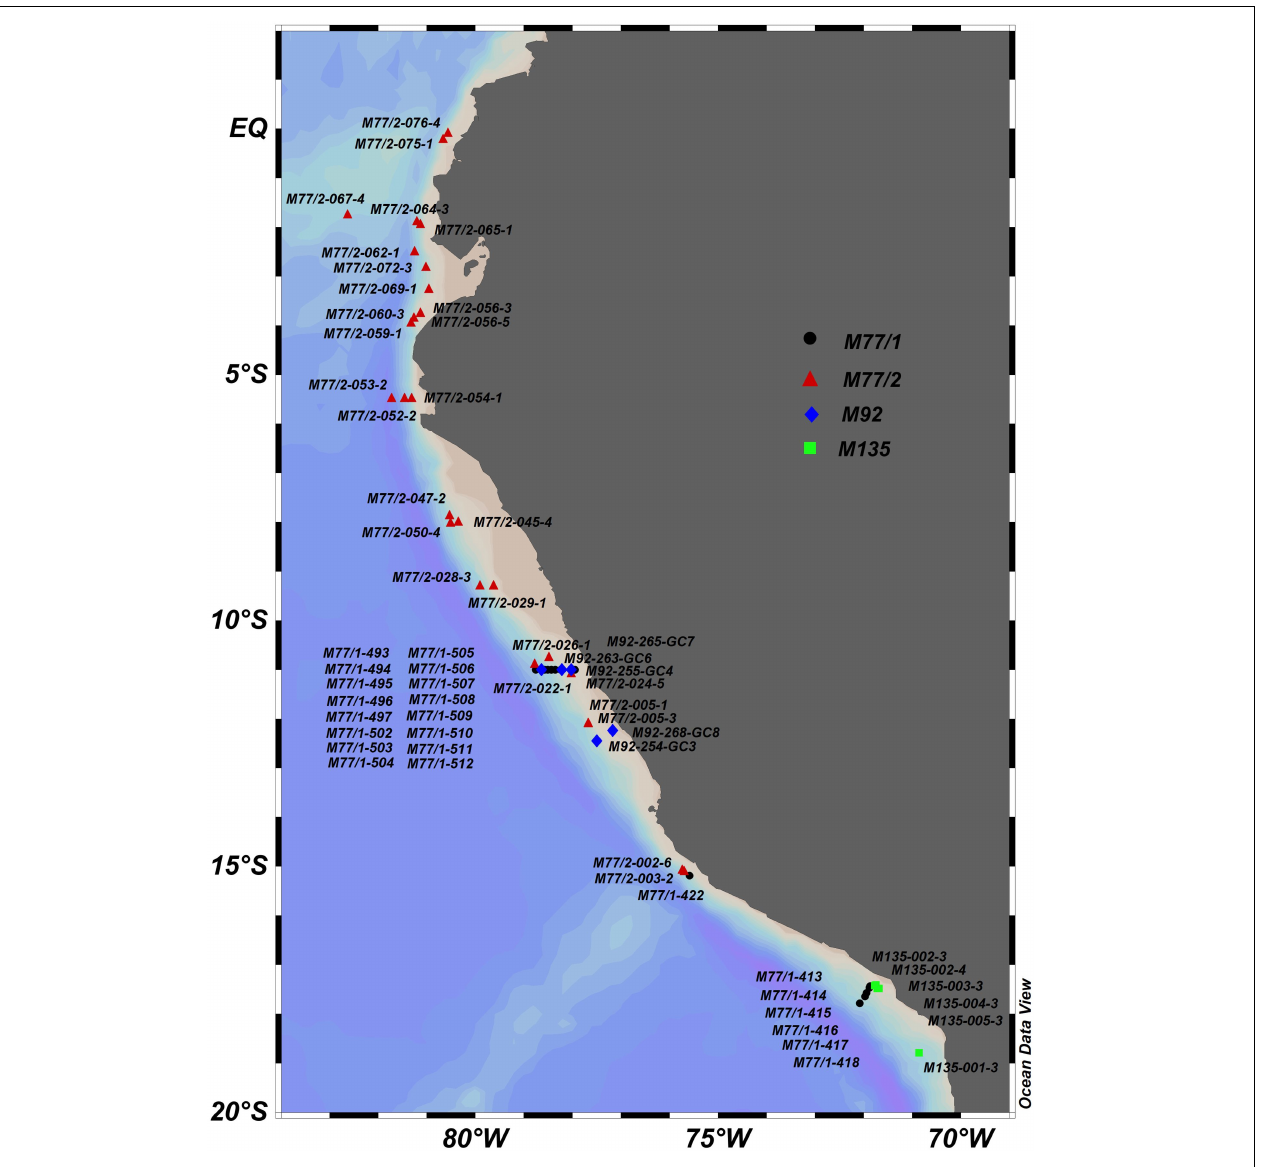
FIGURE 8 | Map of the Eastern Tropical South Pacific showing the location of the gravity cores and piston cores taken during cruises M77/1 (black circles), M77/2 (red triangles), M92 (blue diamonds) and M135 (green squares).